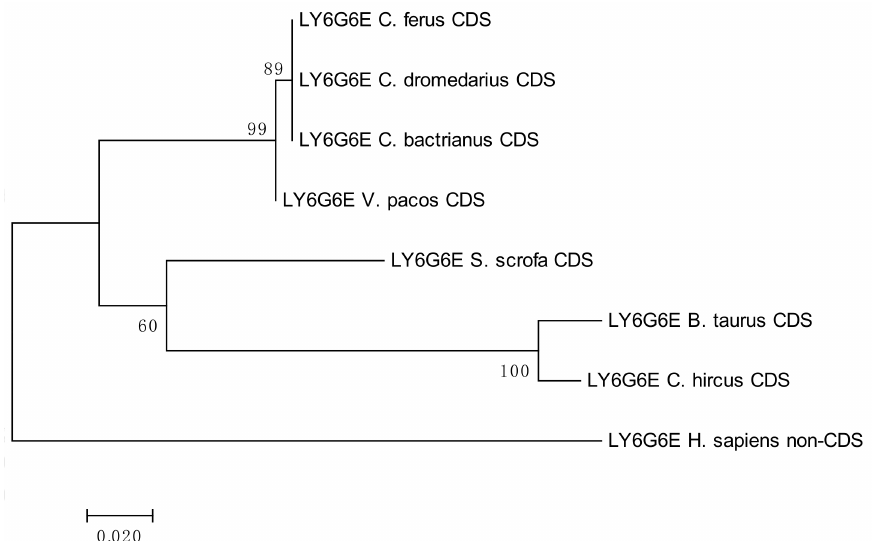
Figure 5. Phylogenetic tree of the LY6G6E CDSs from selected species. The maximum-likelihood method was used based on the Tamura 3-parameter model with gamma distribution (five categories, parameter = 0.5569). The number of bootstraps was 1000.